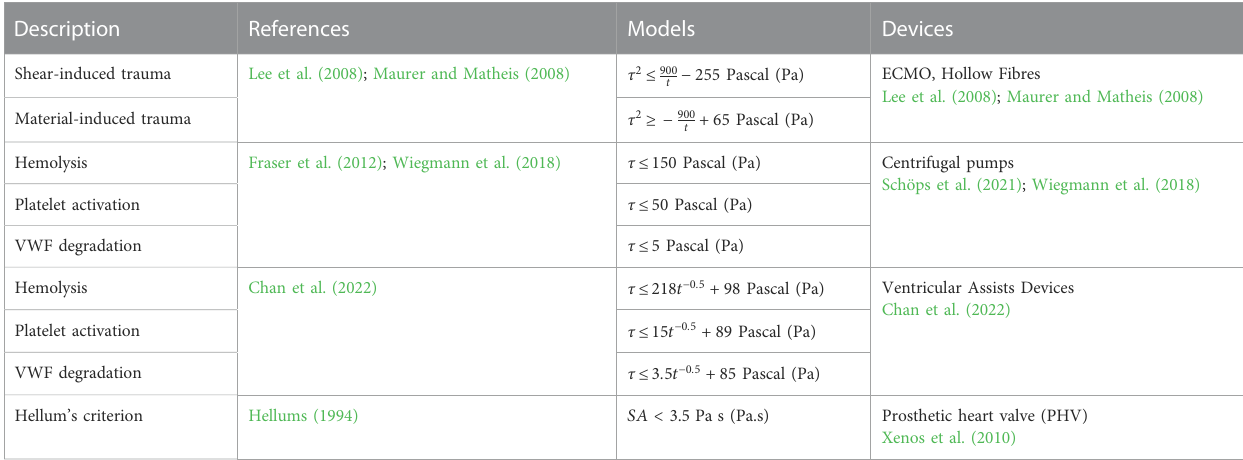
TABLE 2 Existing models based on a thresholding approach for blood